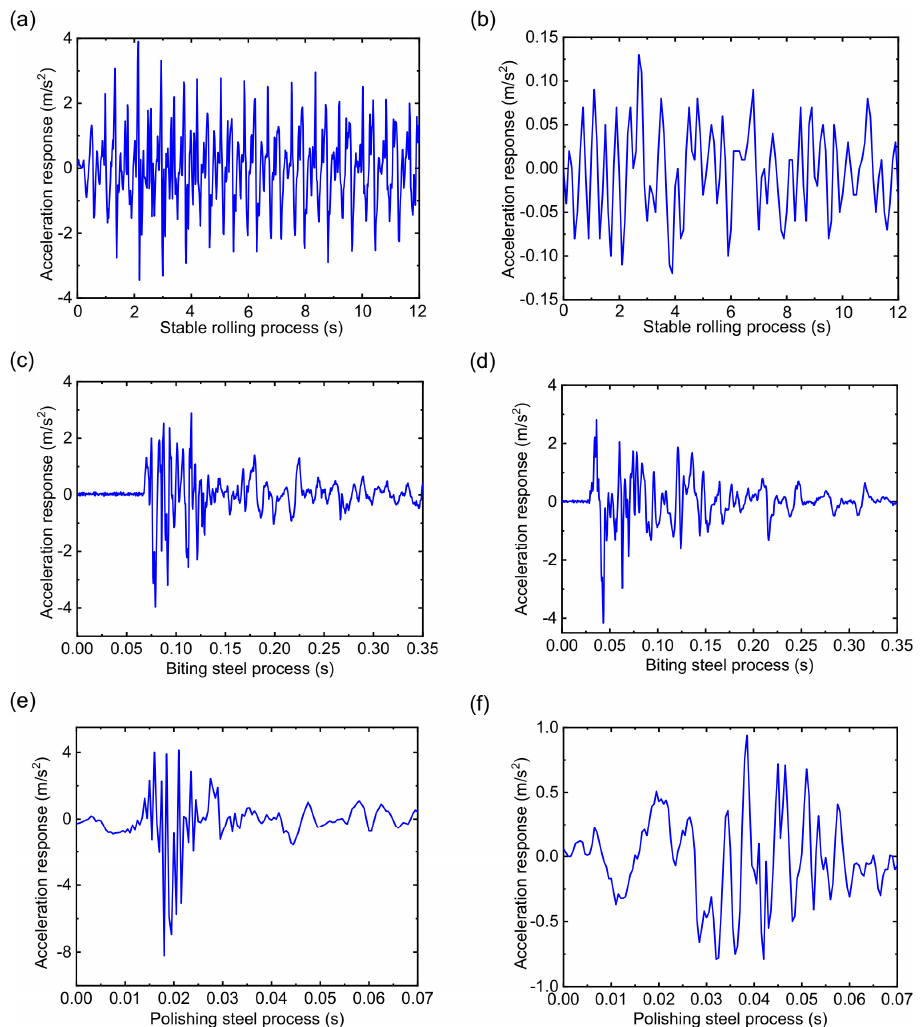
Figure 9. Transient acceleration response of the system: ( a ) stable rolling process of the 1.6 mm, ( b ) stable rolling process of the 3.2 mm, ( c ) biting steel process of the 1.6 mm, ( d ) biting steel process of the 3.2 mm, ( e ) polishing steel process of the 1.6 mm, and ( f ) polishing steel process of the 3.2 mm.